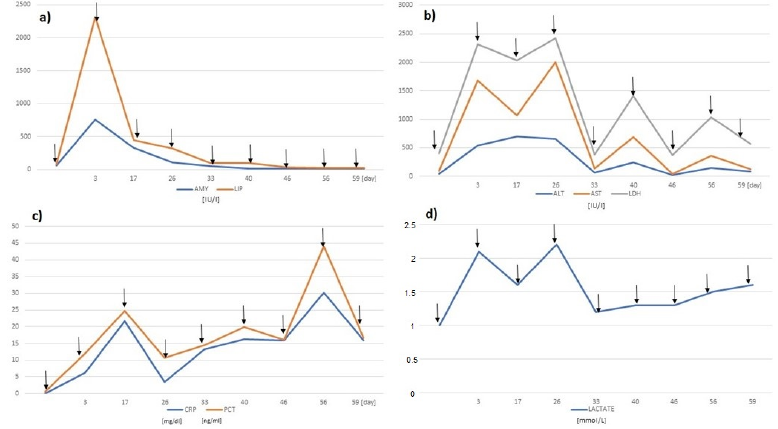
Figure 2. The figure showing the results of biochemical tests in correlation with the performed surgical procedures (marked with arrows). The following tests have been plotted: ( a ) AMY, LIP, ( b ) ALT, AST, LDH, ( c ) CRP, PCT, ( d ) lactate. Normal values for the presented parameters are: AMY 22–80 IU/L, LIP 5–31 IU/L, ALT < 39 IU/L, AST < 48 IU/L, LDH 110–295 IU/L, CRP < 0.5 mg/dL, PCT < 0.5 ng/mL, lactate 0.5–1.6 mmol/L. Abbreviations: AMY—Amylase, LIP—Lipase, ALT—